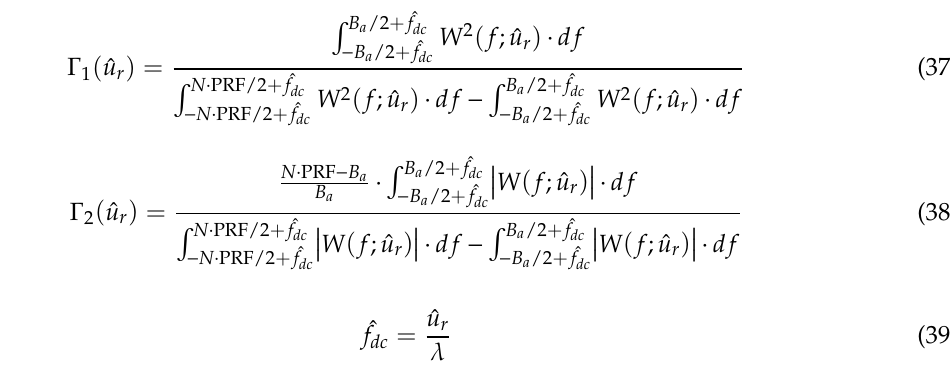
Figure 11. Reconstructed Doppler spectra via different slant range velocities for reconstruction in the non-band - limited case, while the actual target slant range velocity is 10 m/s. ( a ) The slant range velocity for reconstruction is 5 m/s. ( b ) The slant range velocity for reconstruction is 8 m/s. ( c ) The slant range velocity for reconstruction is 10 m/s.